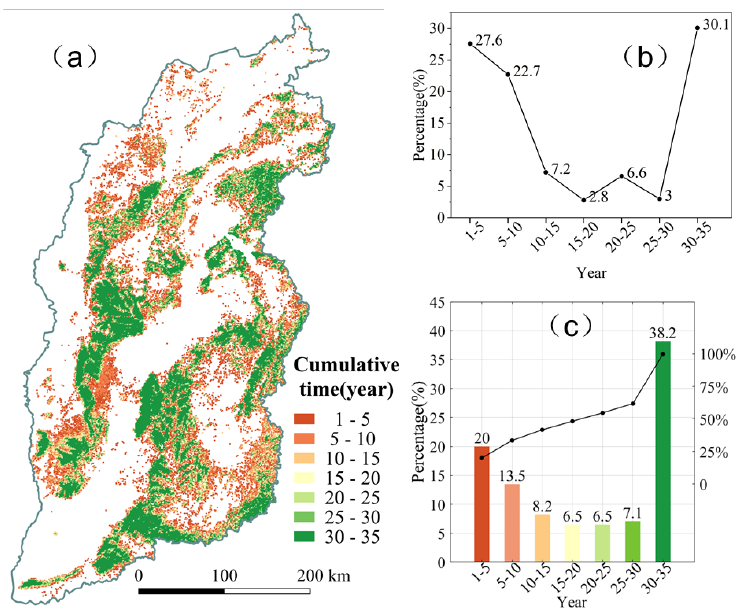
Figure 6. The spatial and temporal distribution of change processes: ( a ) spatial distribution of stable; ( b ) the statistics of duration of stable subsequences; ( c ) the statistics of cumulative time of stable. This study counted all start times for the three change processes (Figure 7). The initial time period (1987–1995) showed an exceptionally high percentage of experiencing the beginning of degradation (21.9%) and a low percentage of the beginning of stability (13.4%). Over time, the beginning of degradation appears less and less; only 0.4% of the degradation processes began in the last time period (2015–2021). During the 2000–2005 time period, the beginning of restoration started to increase and reached a peak (10%) in the period 2005–2010. From the 2005 to 2010 time period, the beginning of the stable process kept increasing until the last time period (2.4%).